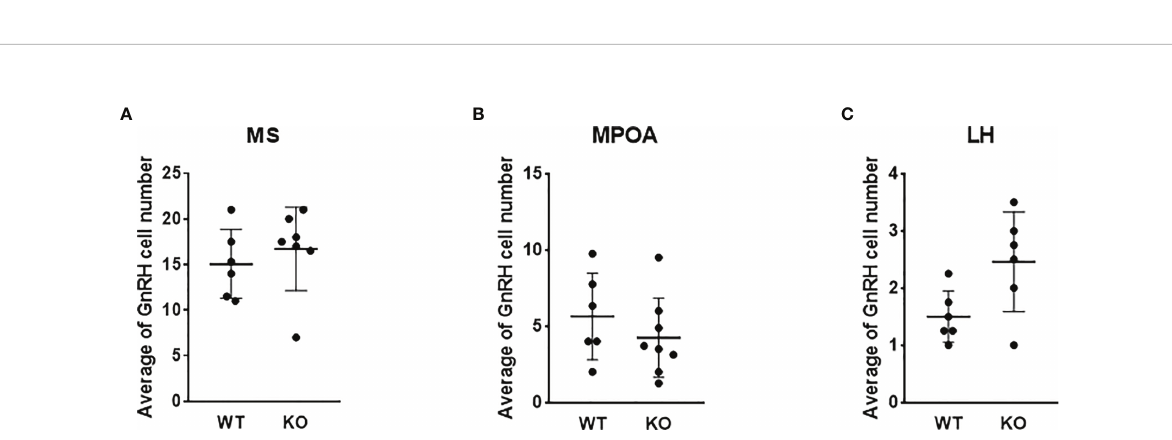
FIGURE 3 Number of GnRH neurons in wild-type and PACAP KO female mice. Summarized data of the number of GnRH neurons in regions of medial septum (MS), medial preoptic area (MPOA), and lateral hypothalamus (LH) from WT and PACAP KO mice are presented in panels (A – C) respectively. Experiments were performed in female mice in estrus phase. Data are presented as mean ± SD, n = 6 –